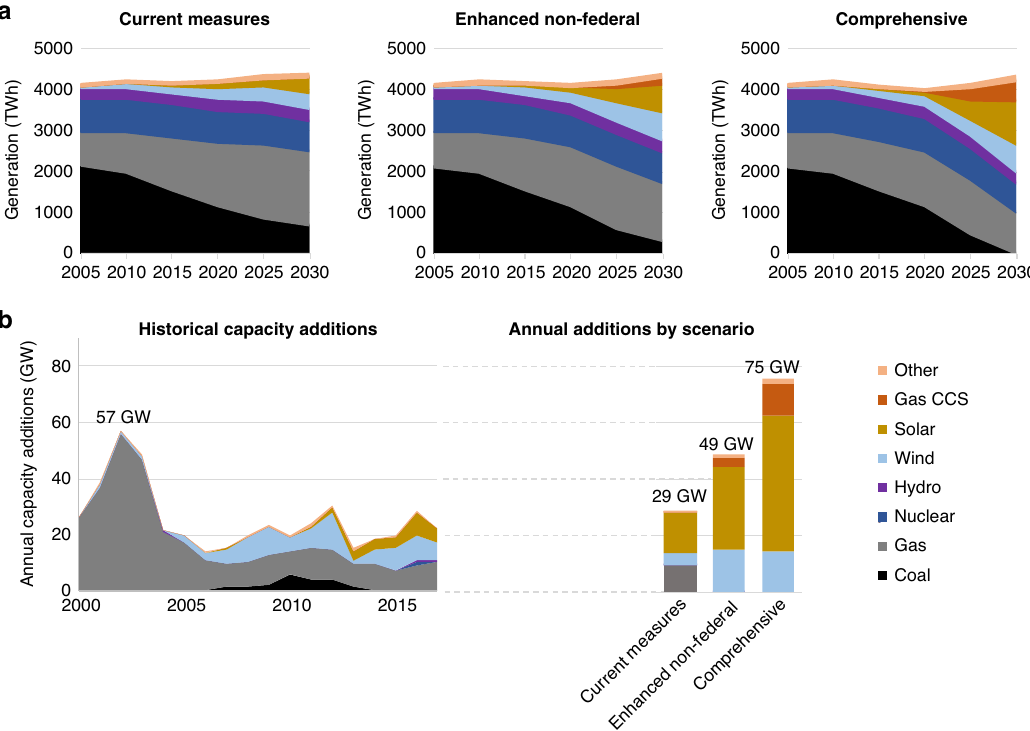
Fig. 4 The pace of the electricity sector transition between 2020 and 2030 surpasses recent historical experience in the U.S. a Electricity generation in the current measures, enhanced non-federal, and comprehensive scenarios. b Annual power sector capacity additions from 2000 to 2017 and estimated rates of annual additions for the three